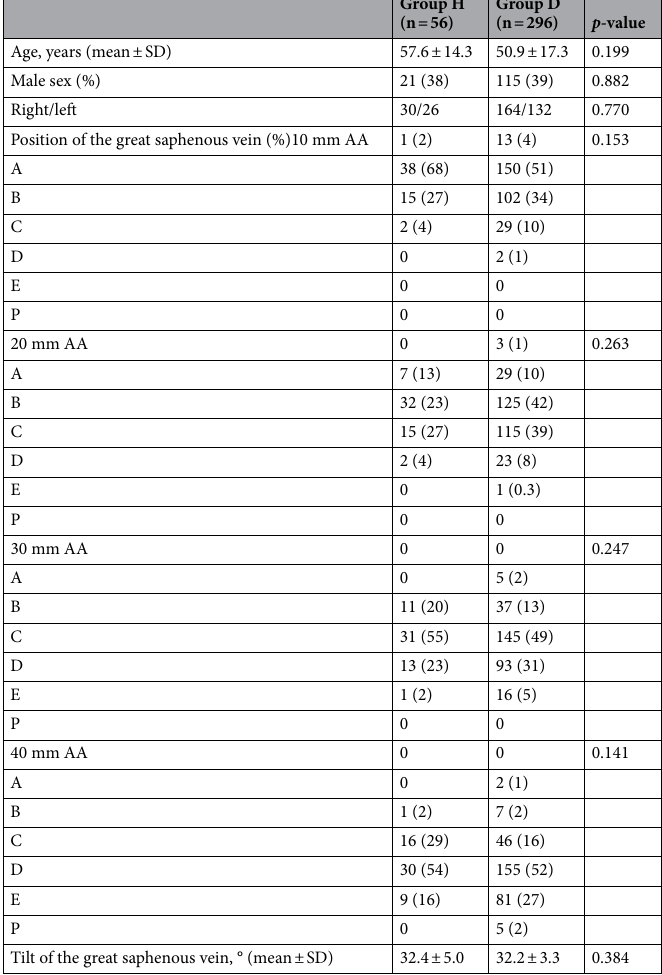
Table 2. Patient demographics. SD standard deviation.